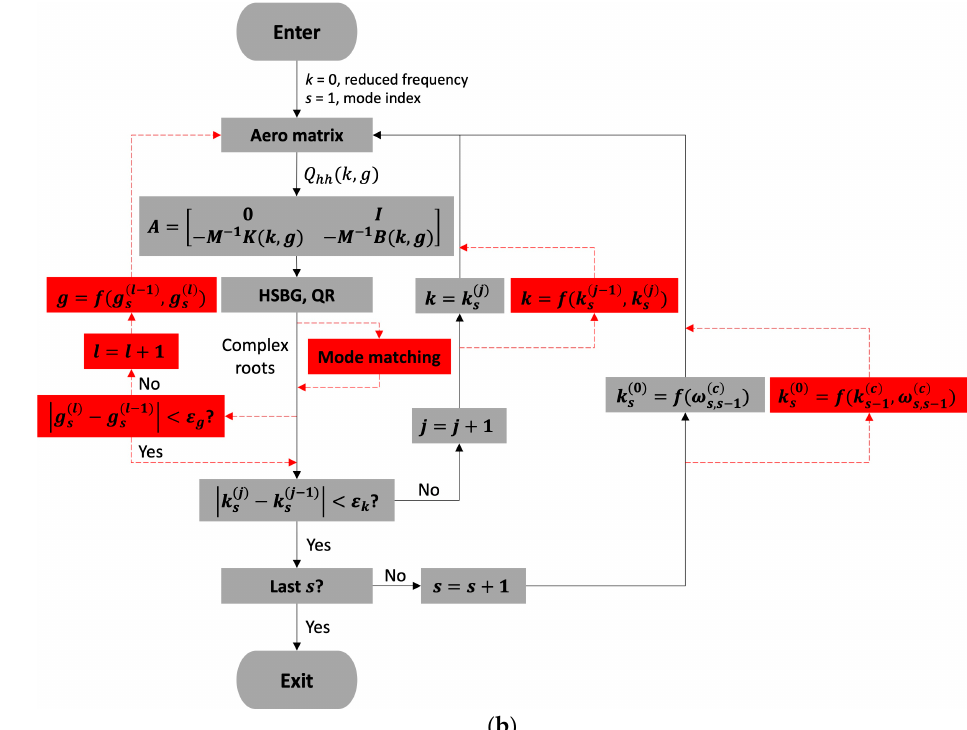
Figure 3. Flow diagram of the modified g-method, adapted from Bellinger [28]. The right flowchart ( b ) represents the damping iteration process added to the left flowchart ( a ). Grey: original processes in NASTRAN; Red: developments in this study.